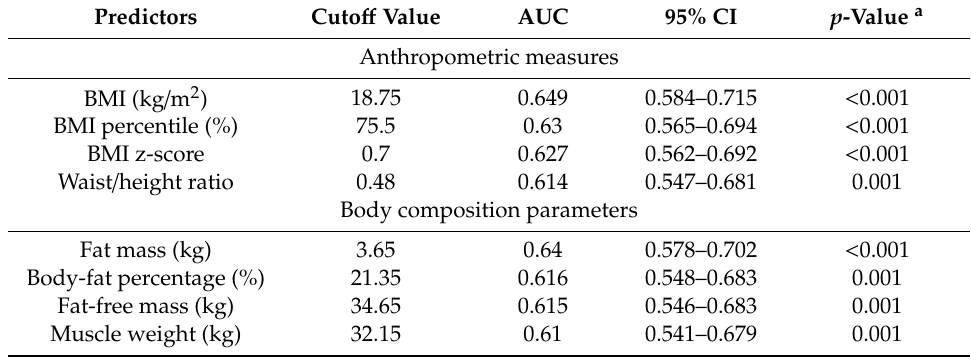
Table 3. Single anthropometric measure or body composition parameter as predictors of pediatric hypertension in the overall cohort, in descending order of area under the curve (AUC).